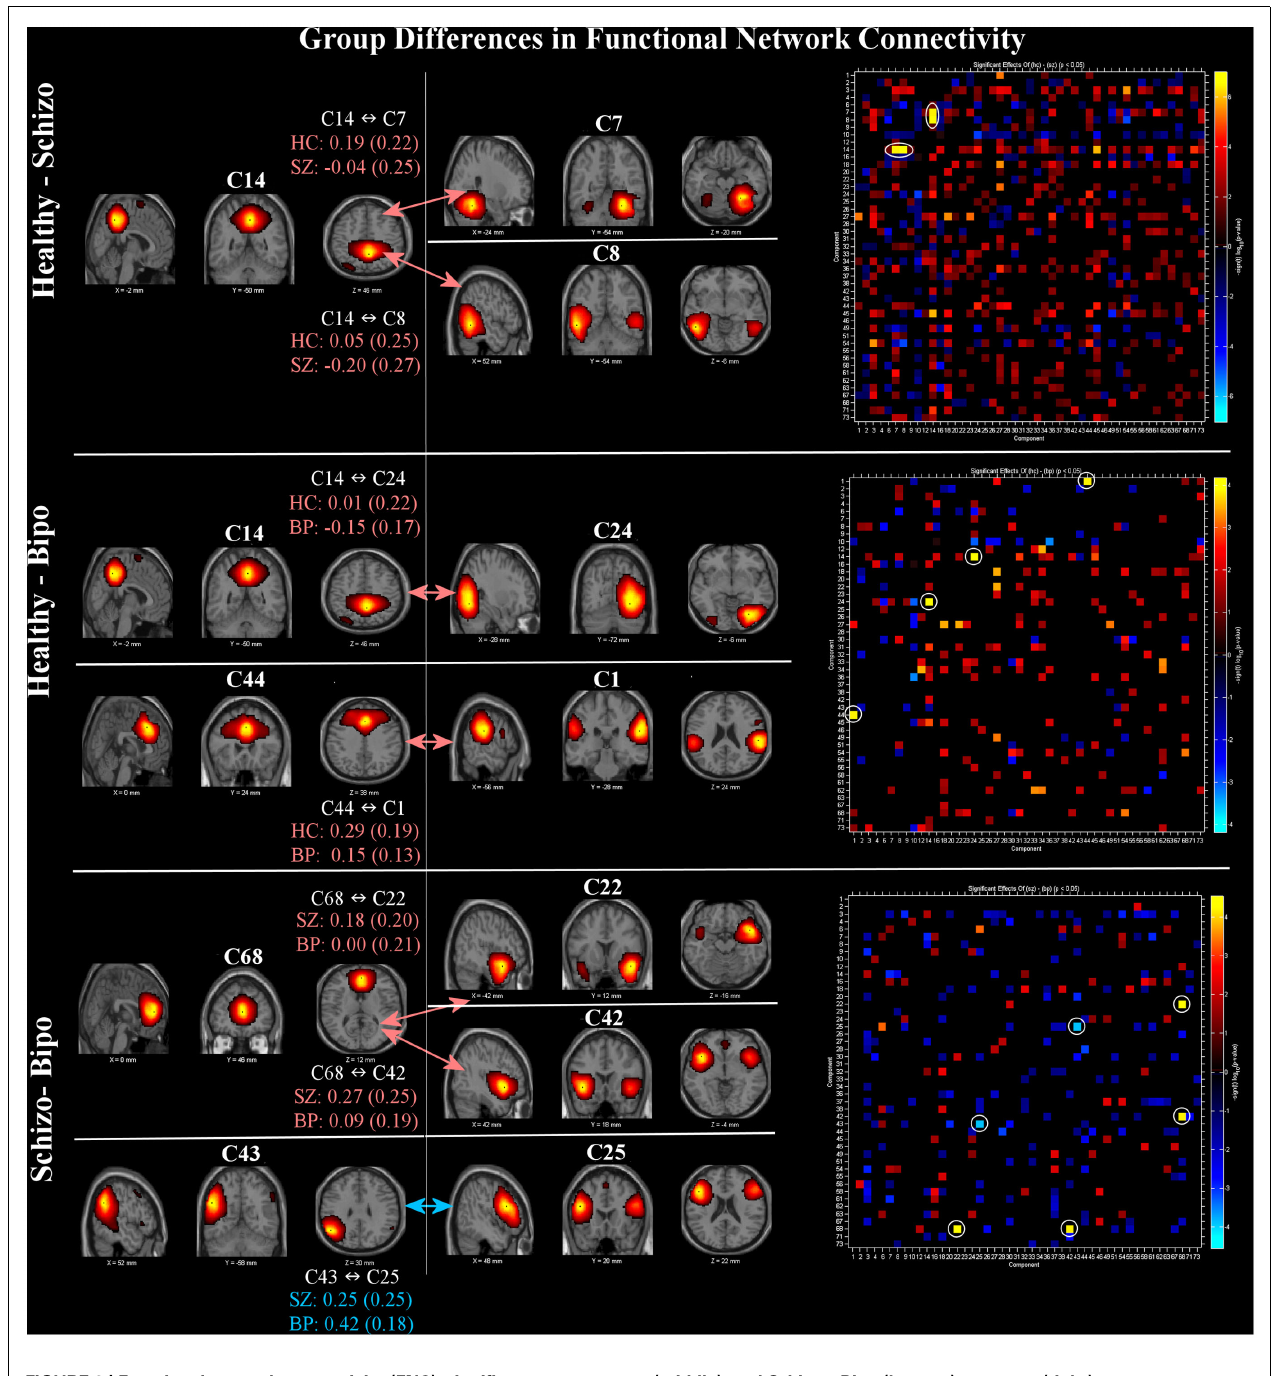
FIGURE 2 | Functional network connectivity (FNC): significant between-group differences (thresholded at p < 0.05, corrected for multiple comparisons) in FNC (left) and full difference matrices (thresholded at p < 0.05, not corrected, to provide additional context) for Healthy – Schizo (top), Healthy – Bipo